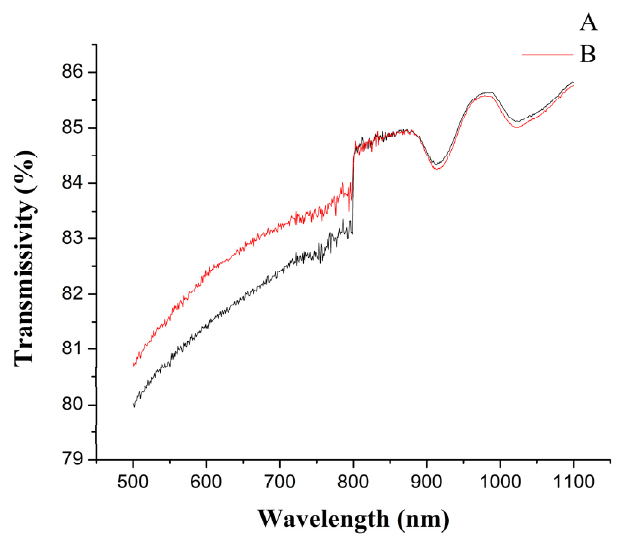
Figure 8. The transmissivity of PP at different wavelengths before and after grafting